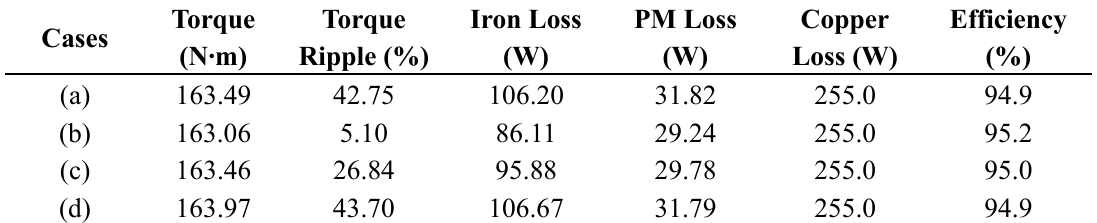
Table 7. Motor Performance in Two-Phase-Open